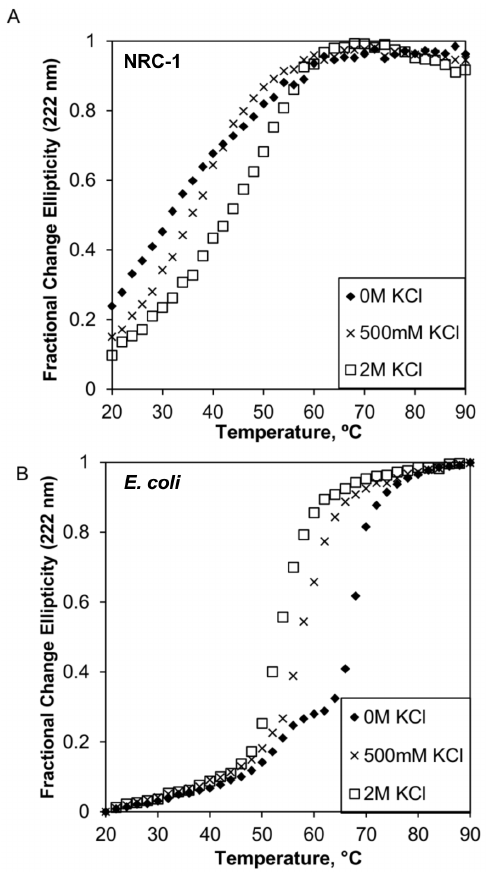
Figure 4. Thermal denaturation curves of NRC-1 and E. coli CysRS monitored by CD spectroscopy at 222 nm. Thermal denaturation experiments performed on NRC-1 (A) and E. coli (B) CysRS in three concentrations of KCl: 0 M ( ¤ ), 500 mM ( 6 ), 2 M ( % ). The midpoint of the curve was used to calculate the melting transition temperatures (TM) for each